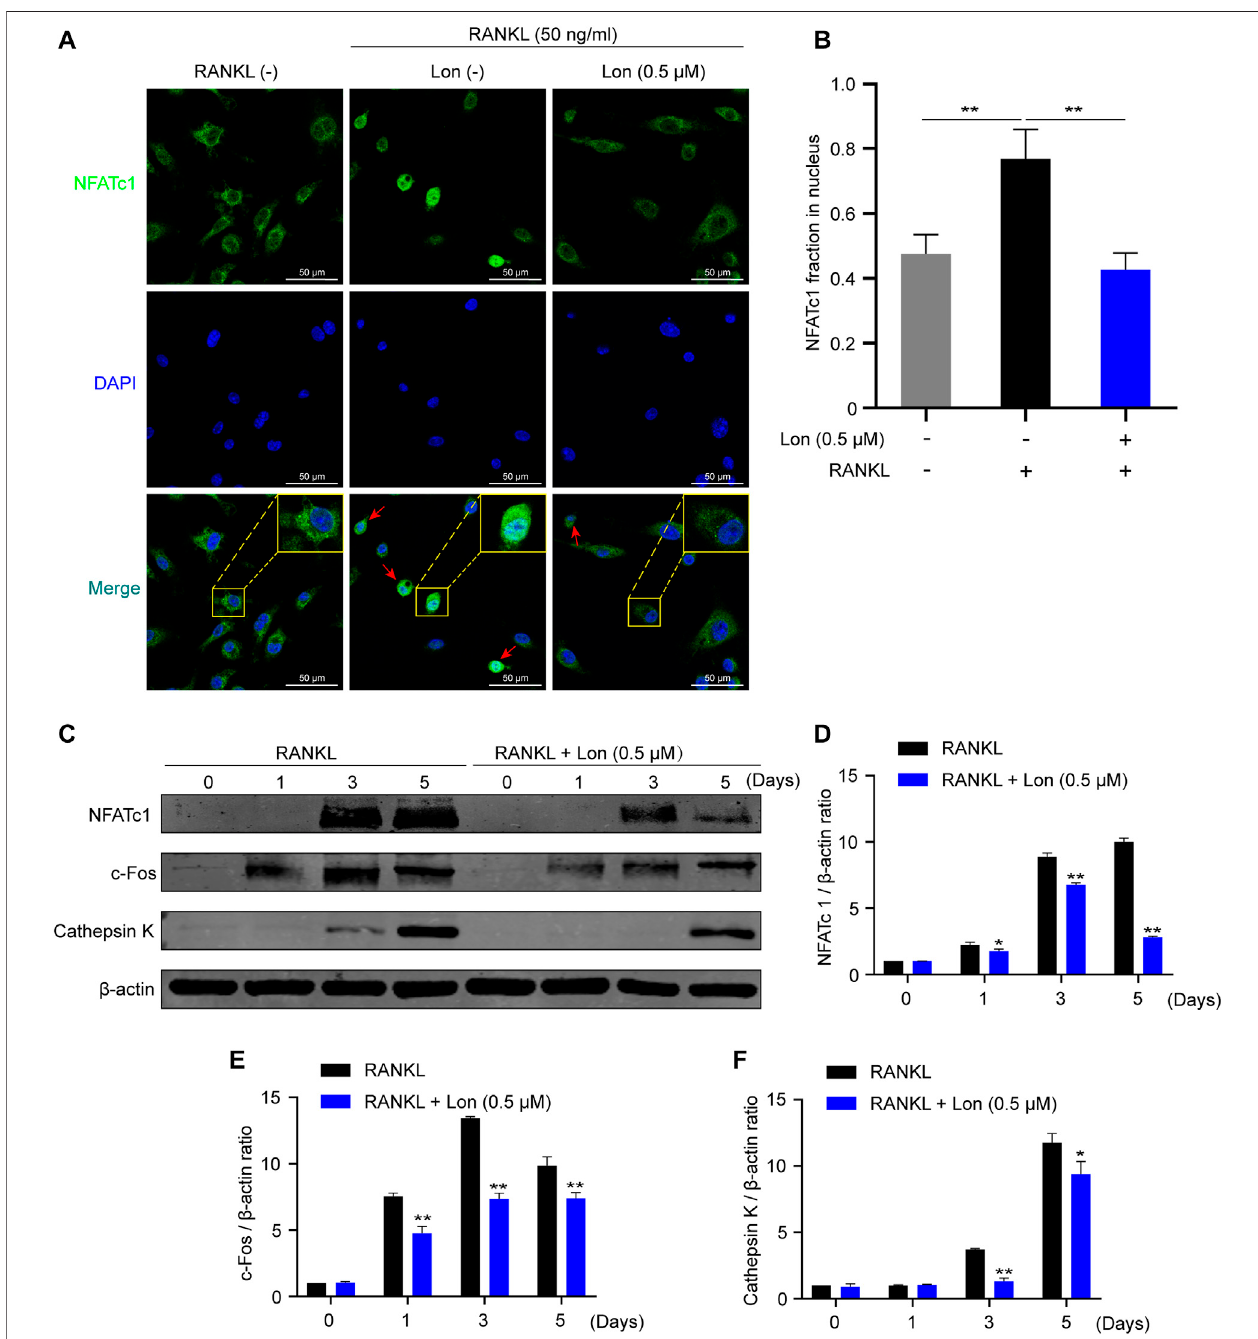
FIGURE6| LonsuppressesNFATc1nucleartranslocationandosteoclast-relevantproteinexpression. (A) ThesuppressiveeffectofNFATc1nucleartranslocation treatingwithLonwasobserved viaNFATc1 immuno fl uorescence staining. (B) Relative NFATc1 fraction in nucleus wascalculatedthrough densitometric analyses( n =4 per group). (C) Representative Western Blot images of the expression levels of NFATc1 and osteoclast-related proteins including c-Fos, and Cathepsin K during osteoclastformation. (D – F) Quanti fi cationoftheratiosofbandintensityofNFATc1,c-Fos,andCathepsinKrelativeto β -actin ( n =3pergroup).Alloftheabovedata are expressed as the mean ± SD. * p < 0.05, ** p < 0.01 relative to RANKL-induced control group. BMMs, bone marrow macrophages; c-Fos, Proto-oncogene C-Fos; Lon, Lonafarnib; NFATc1, nuclear factor of activated T cells 1; RANKL, receptor activator of nuclear factor- κ B ligand.